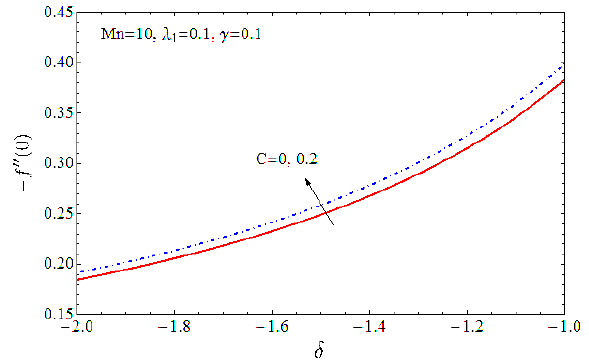
Fig. 8 Dimensionless skin friction coefficient − f (cid:48)(cid:48) ( 0 ) versus λ 1 for different values of Mn.